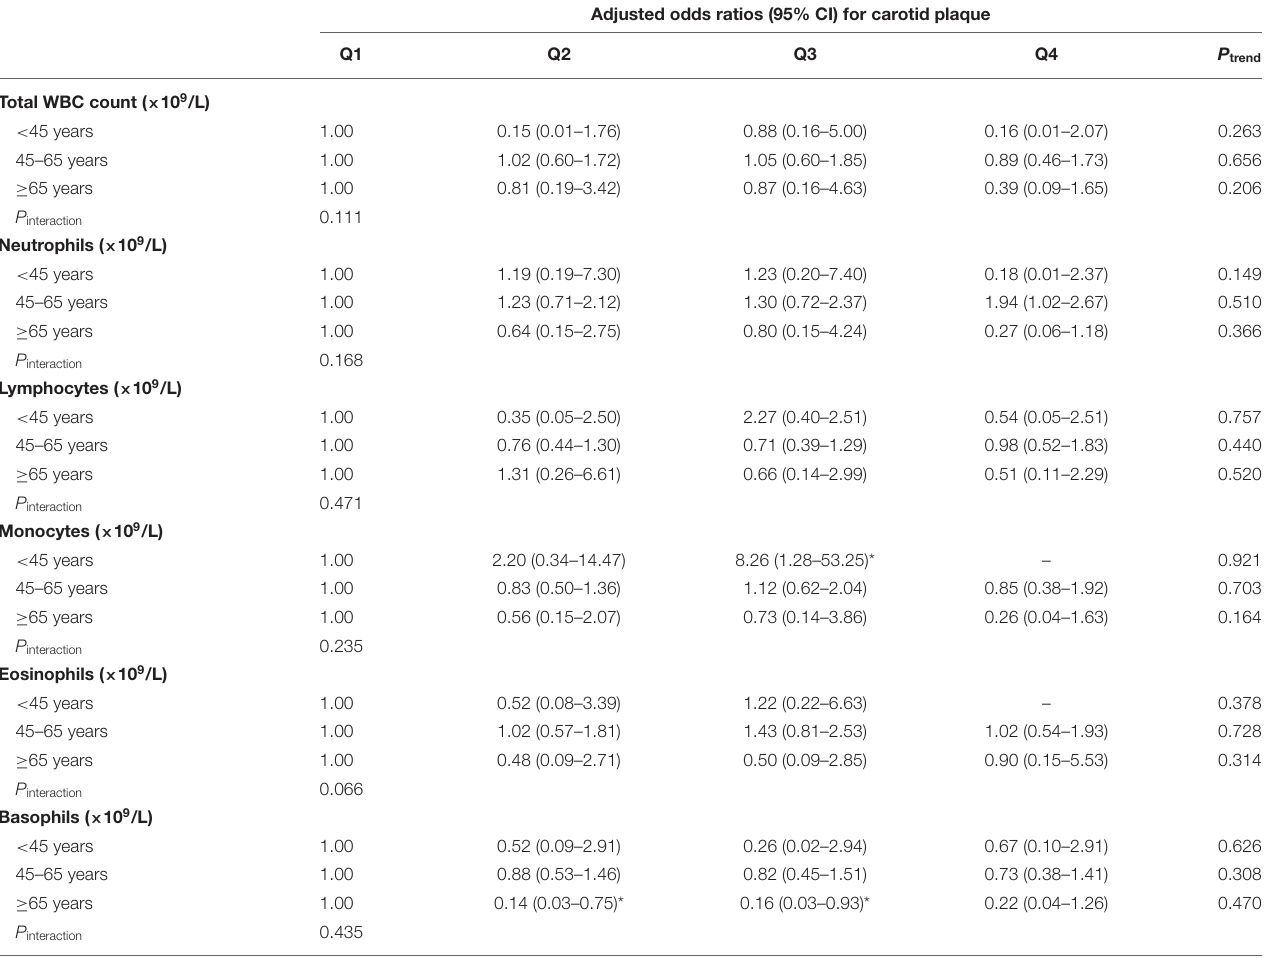
TABLE 5 | Adjusted odds ratios and 95% CI for carotid artery plaque stratified by age for